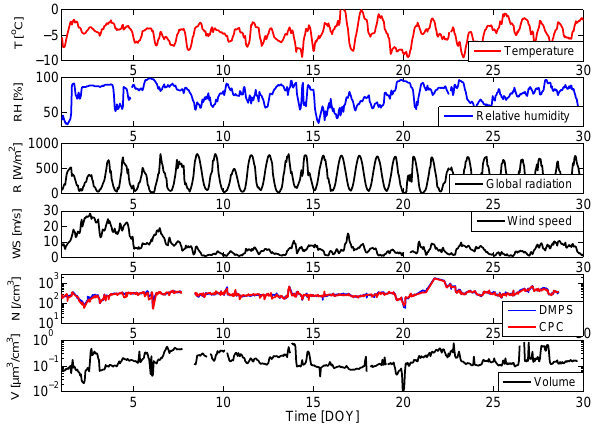
Fig. 2. Weather parameters and aerosol total number and volume concentrations measured at Aboa. Panels present temperature, rel- ative humidity, global radiation, wind speed, particle total num- ber and particle total volume in January 2007 from top to bottom, respectively. Both the intergrated number concentration from the DMPS data and the total number measured with CPC are presented. The volume concentration is calculated from the DMPS data.